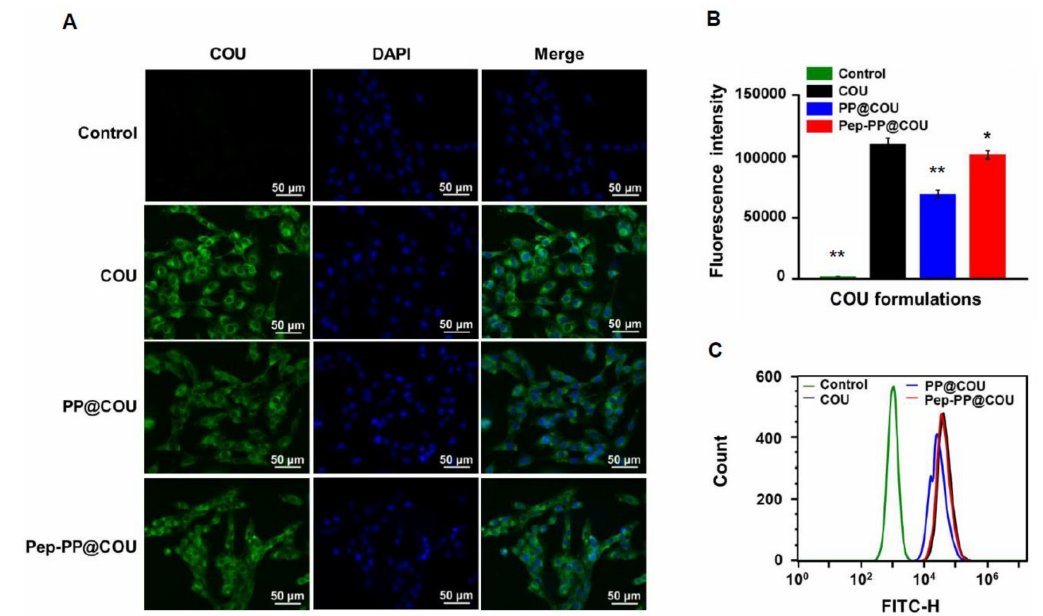
Figure 3. Evaluation of nanoparticle internalization efficacy via quantification of cellular uptake of COU, PP@COU and Pep-PP-COU. Cellular uptake of COU, PP@COU and Pep-PP-COU was illustrated ( A ) and quantified ( B ) through tracing COU fluorescent intensities. Scale bar, 50 µ m. Quantitative analysis of cellular uptake using flow cytometry ( C ). Note: * and ** indicate p -values < 0.05 and < 0.001, respectively, when compared with